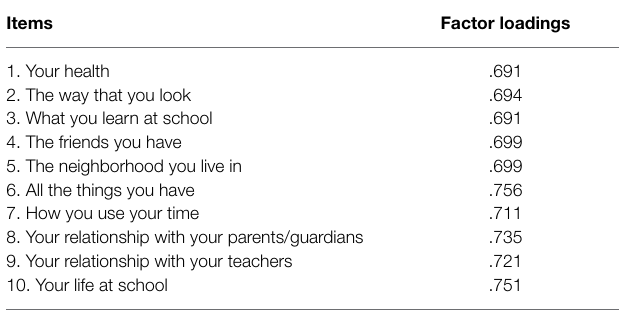
TABLE 2 | Reliability and convergent validity of subjective wellbeing ( N = 63,228). Items